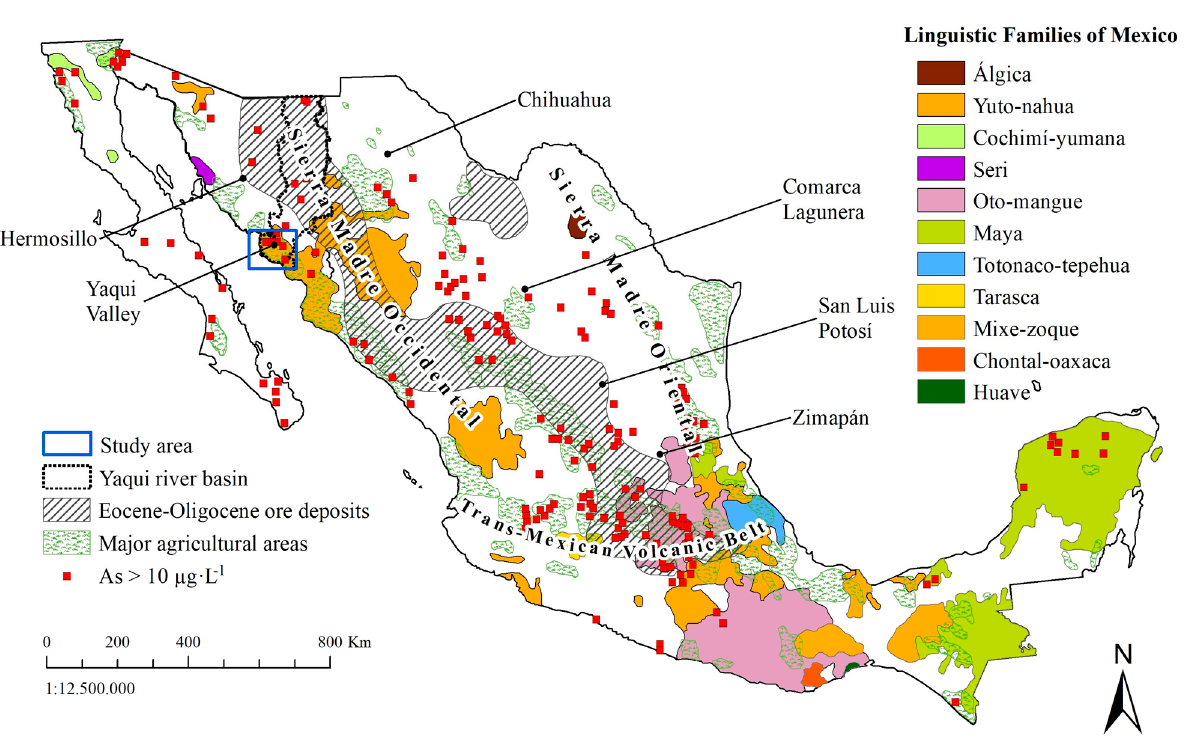
Figure 1. Modified map of Mexico indicating the presence of arsenic (>0.01 mg · L − 1 ) in water wells. Location of populations where people speak different language families (indigenous groups), ore deposits, and major agricultural areas are considered. Research in toxicology has been reported for the places indicated with bold lines (e.g., Comarca Lagunera, San Luis Potosí, etc.).